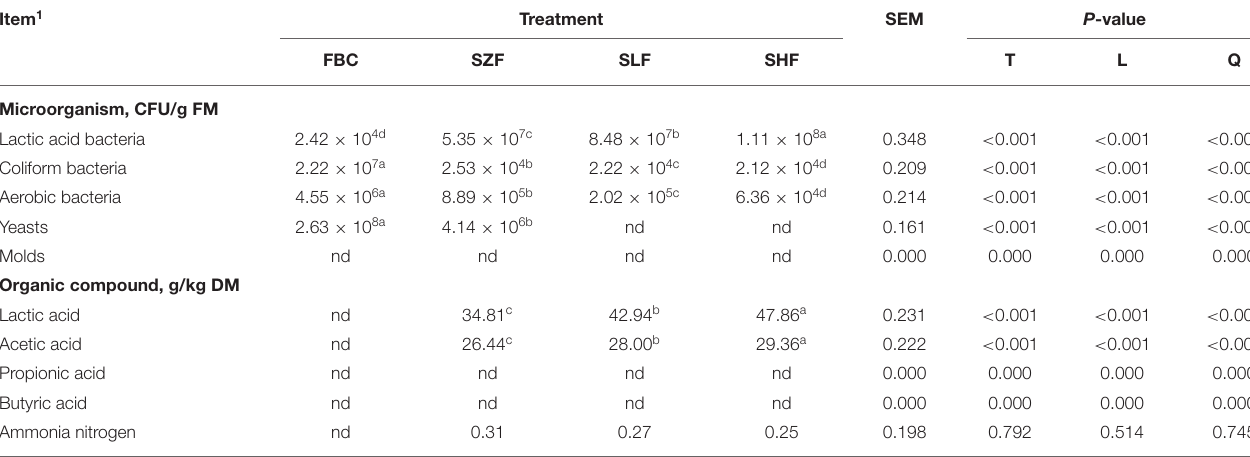
TABLE 2 | Microbiological count and organic component concentration of black cane prior to ensiling (pre-ensiled materials) and silages treated with ferrous sulfate heptahydrate after 21 d. Item